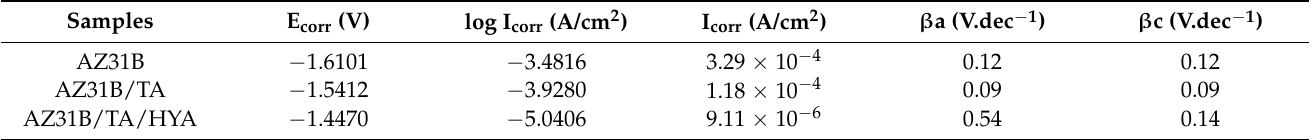
Table 5. E corr and I corr data on AZ31B, AZ31B/TA, and AZ31B/TA/HYA samples.